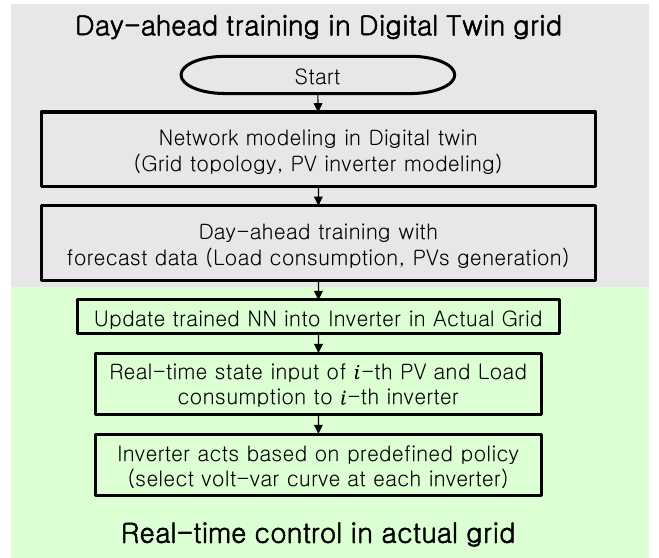
Figure 6. Information flow of the day-ahead training in the digital twin and implementation in the actual grid.